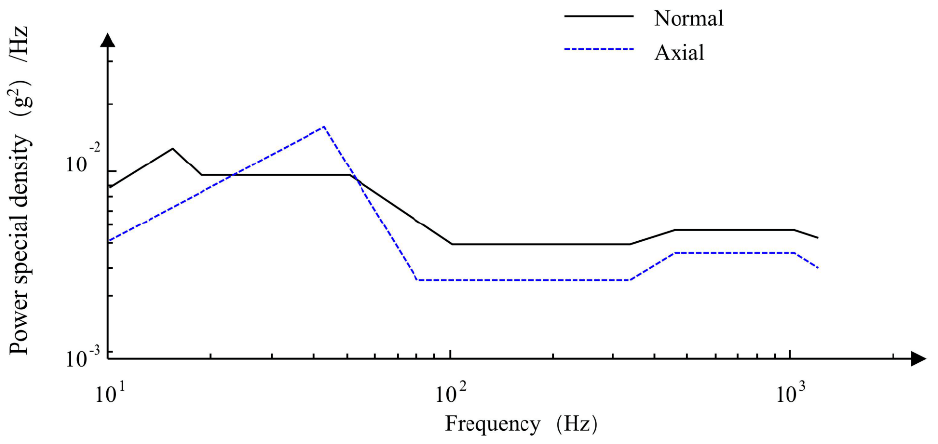
Figure 3. Simulation analysis of the vibration stress distribution.